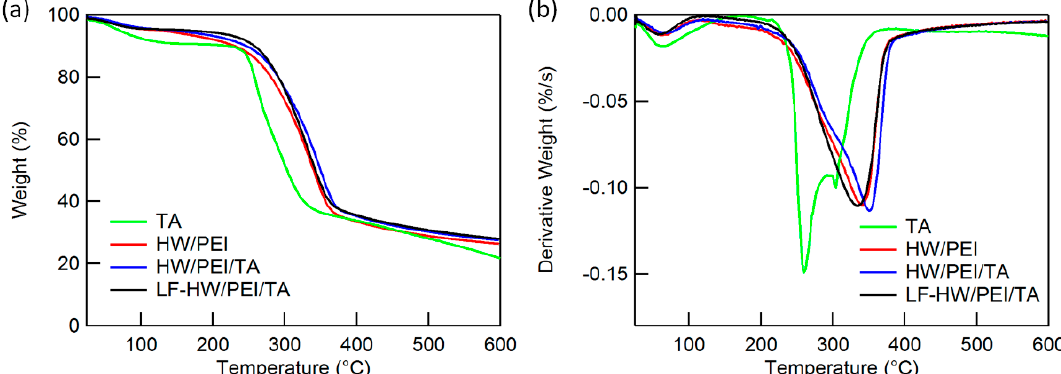
Figure 9. Comparison between TA, HW / PEI, HW / PEI / TA and LF-HW / PEI / TA: ( a ) TG and ( b ) DTG. Table 4. TGA results of ECAP consolidated HW biocomposites.